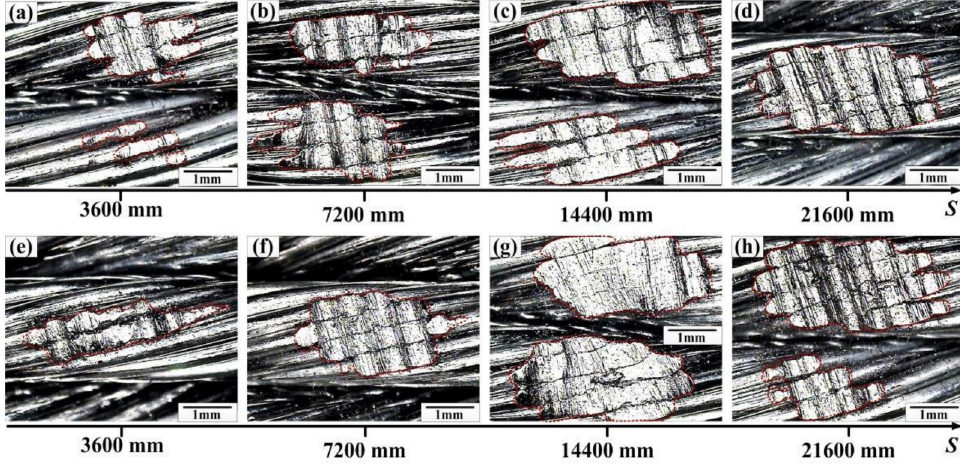
Figure 9. Optical micrographs of the wear scars under different strokes. ( a – d ) Stroke: 20 mm, load: 100 N; ( e – h ) stroke: 30 mm, load: 100